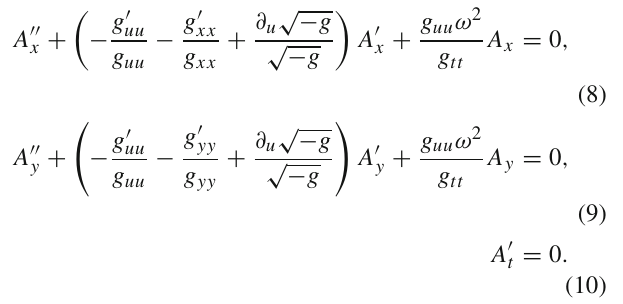
Fig. 1 Real and imaginary parts of the diagonal AC conductivity as functions the θ -angle and the dimensionless frequency variable, w = 3 ω/ 4 π T , for C (cid:12) = (cid:12) L / 2 = 1 (dimensionless combination involv-